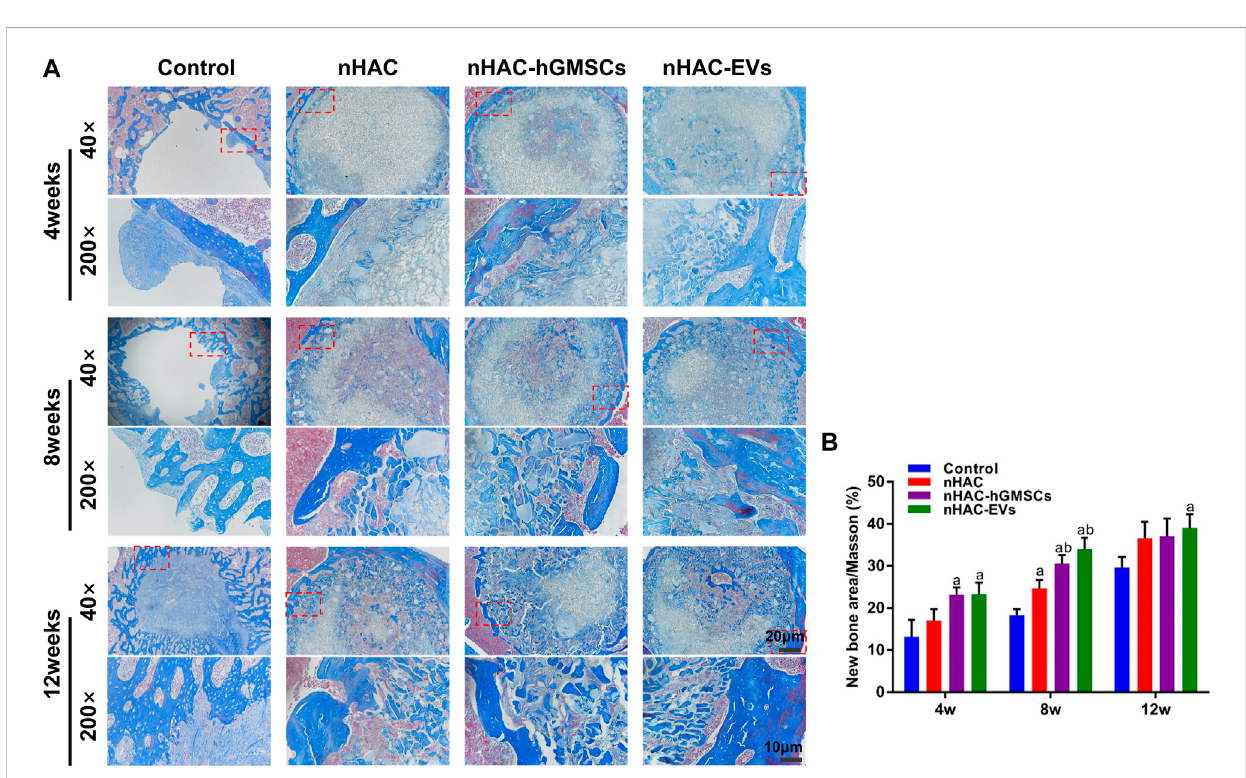
FIGURE 7 Masson staining results of bone regeneration (A) Representative images of Masson staining of the bone defect area. The 200× image is an enlargement in the dashed box of the 40× image (B) Quantitative analysis of new bone. a, p < 0.05 compared with the control group; b, p < 0.05 compared with the nHAC